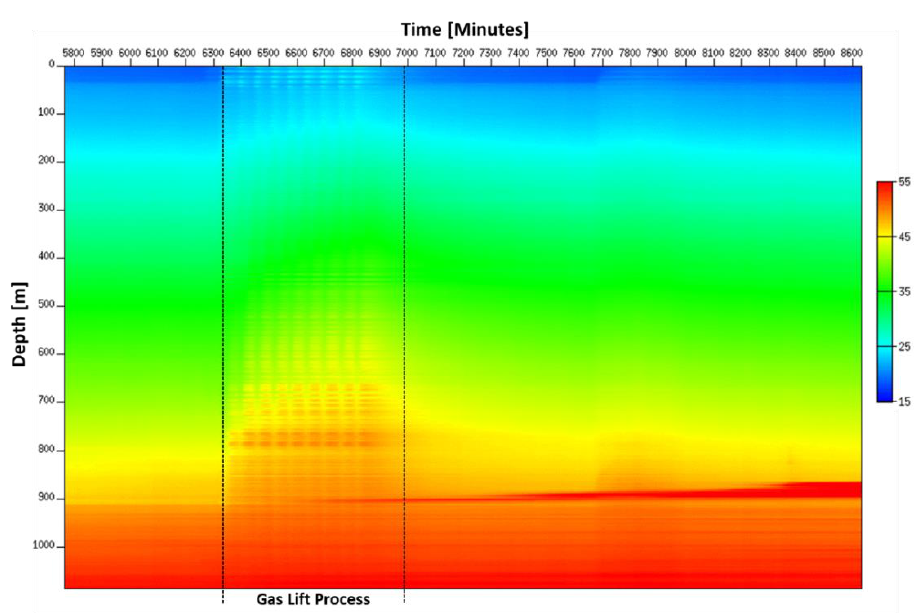
Figure 20. Heat map of entire gas lift operation in May